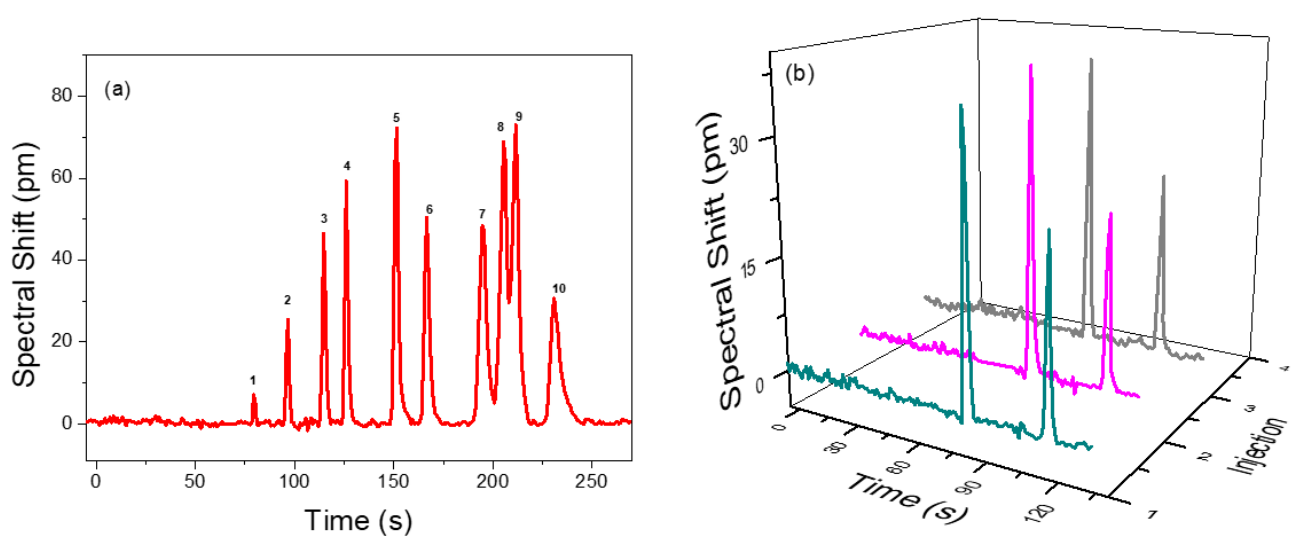
Figure 5. ( a ) Temperature programmed chromatogram for a VOC panel consisting of 10 VOC in a 10 m Rtx-5MS column with helium as the carrier gas flowing at 1 mL/min. Details of the identified peaks are provided in Table 3. ( b ) Repeatability of the separation demonstrated with a mixture of benzene (82 ng) and pentane (776 ng) under the same conditions over three consecutive injections.